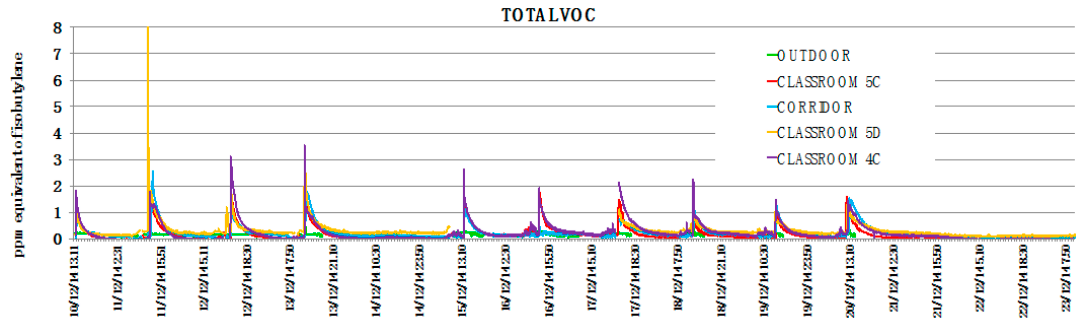
Figure 8. Trend of total volatile organic compounds (TVOC) concentration in all monitored sites for the entire sampling period.